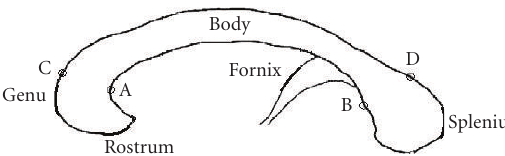
Figure 1: CC structure and partition of the CC boundary (image modified based on original illustration from